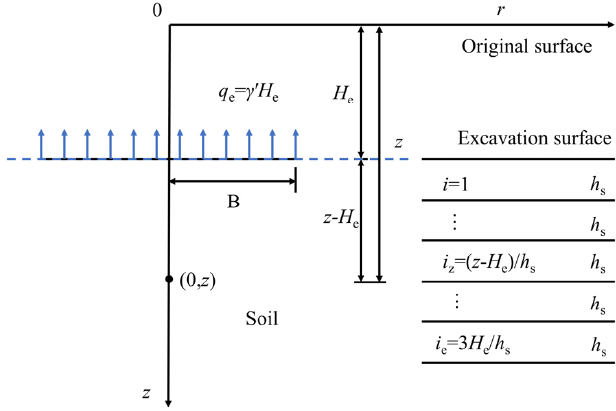
Figure 2. Schematic of basal heave calculation.